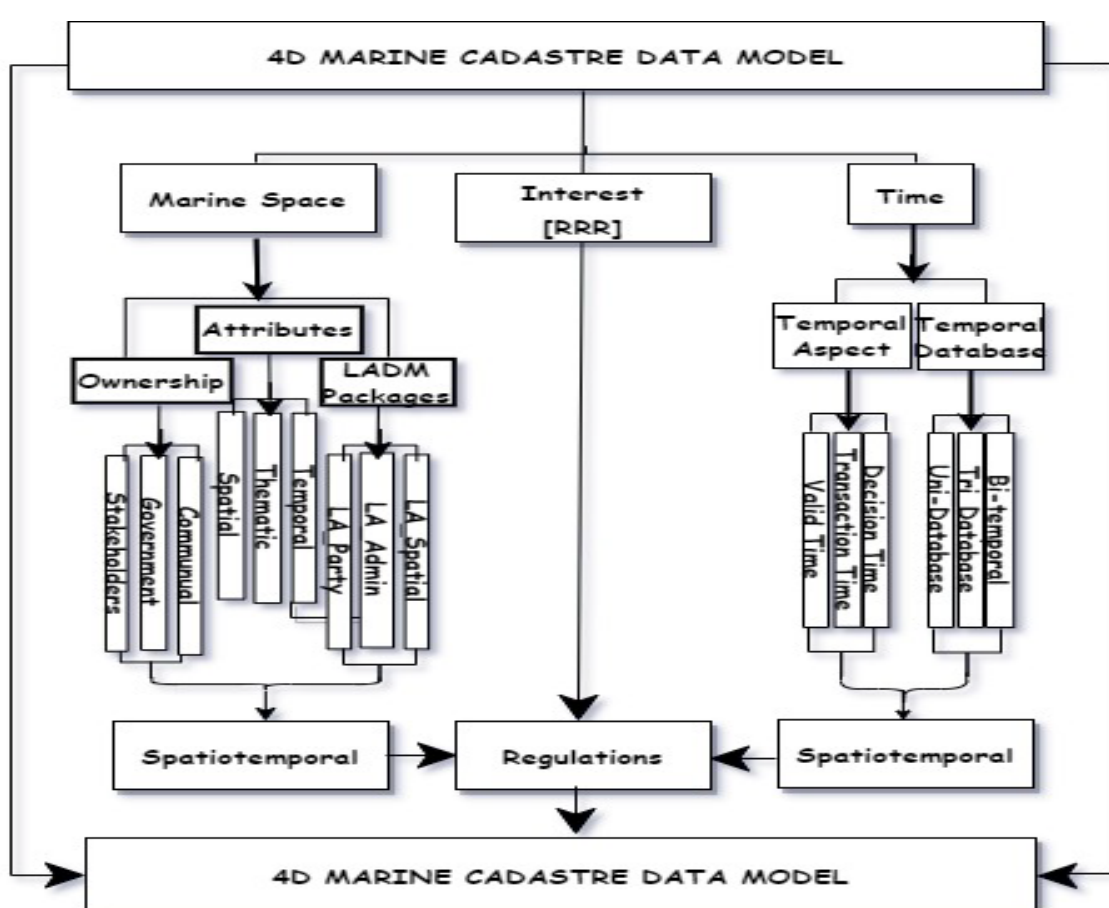
Figure 3. Proposed 4D Marine Cadastre Data